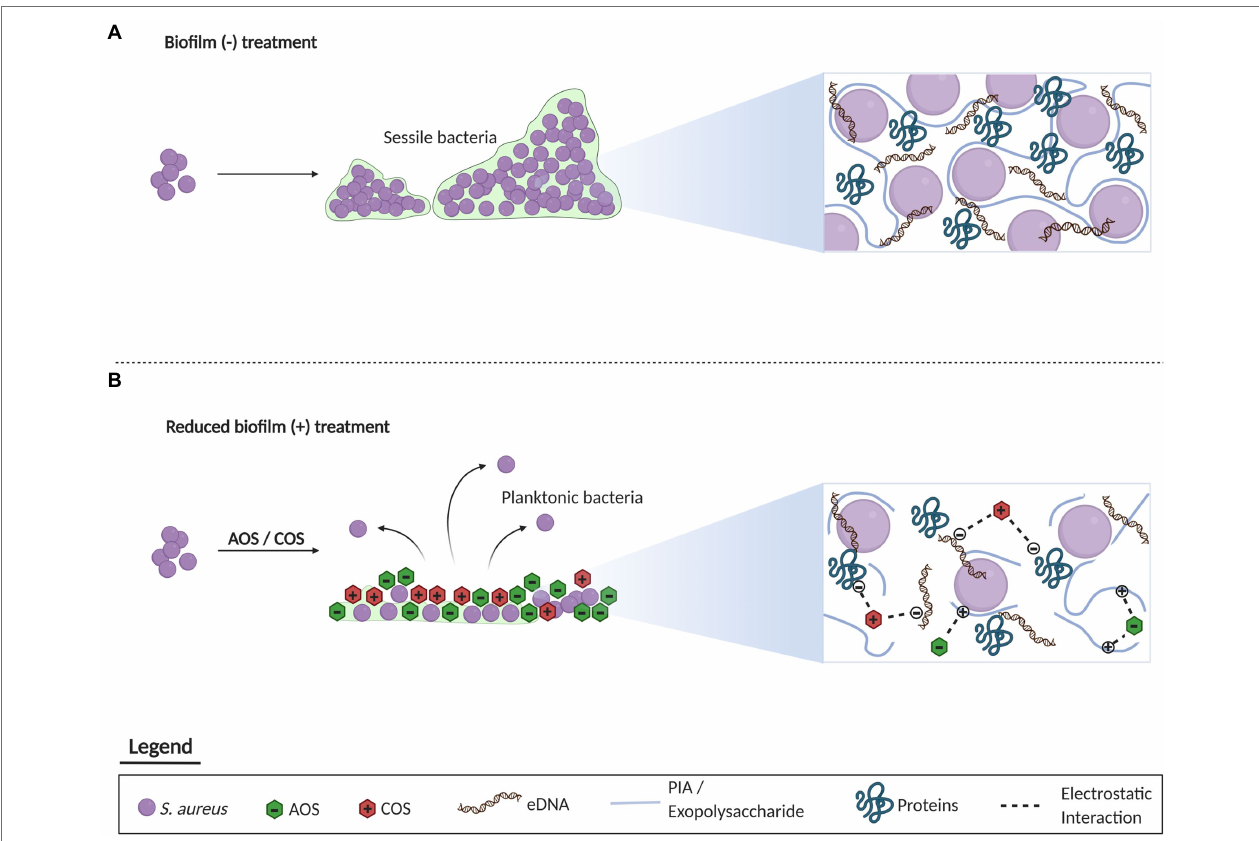
FIGURE 6 | Representation of the proposed mechanism underlying the inhibitory effect of AOS and COS on biofilm formation of S. aureus . Concerning the untreated biofilm, a mature biofilm is formed by S. aureus in the absence of any treatment mainly composed of PIA, eDNA, and proteins (A) . On the other hand, administration of AOS and COS may inhibit the formation of biofilm through the electrostatic interaction of oligosaccharides with the charged components of the extracellular matrix (B) . This figure was created with